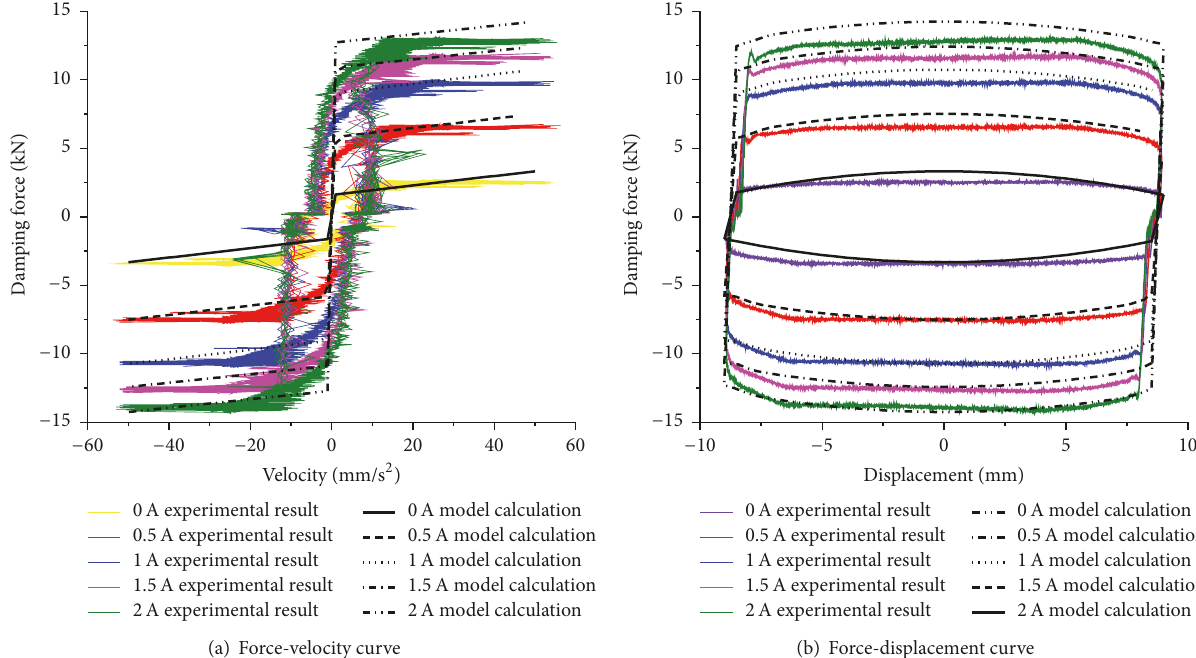
Figure 5: Comparison between model calculation and experimental result for different currents.